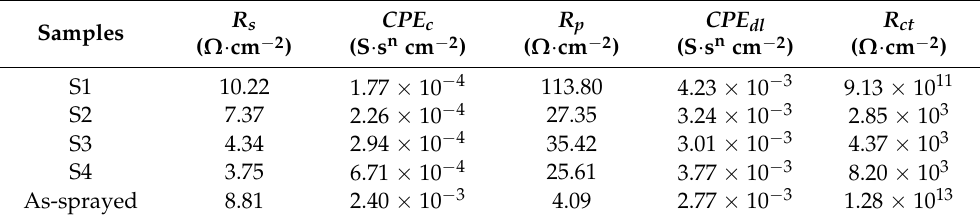
Figure 10. Equivalent circuit used to fit EIS results. Table 4. Electrochemical parameters obtained from EIS spectra of the coating